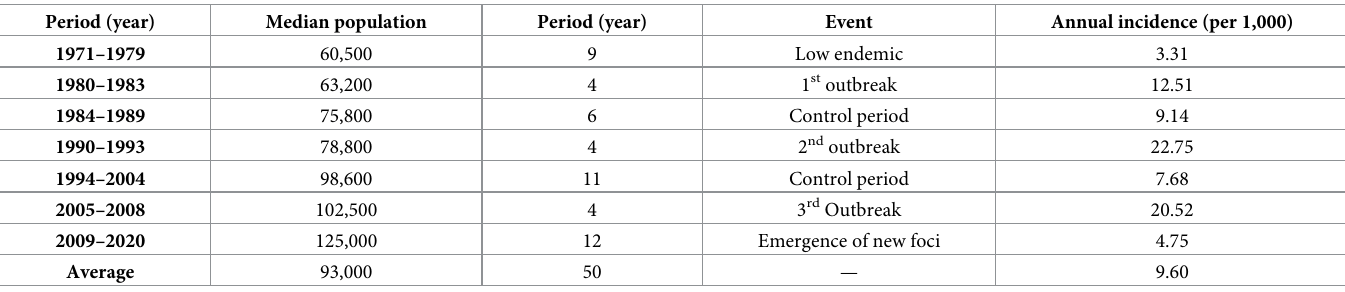
Table 1. Representing the baseline population of patients with cutaneous leishmaniasis in Bam, southeastern Iran, 1971–2020. Period